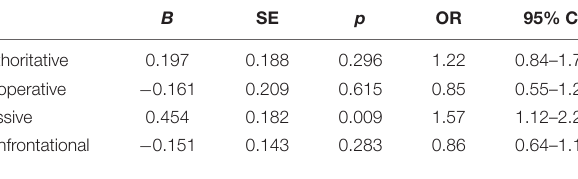
TABLE 8 | Adaptive interviewing